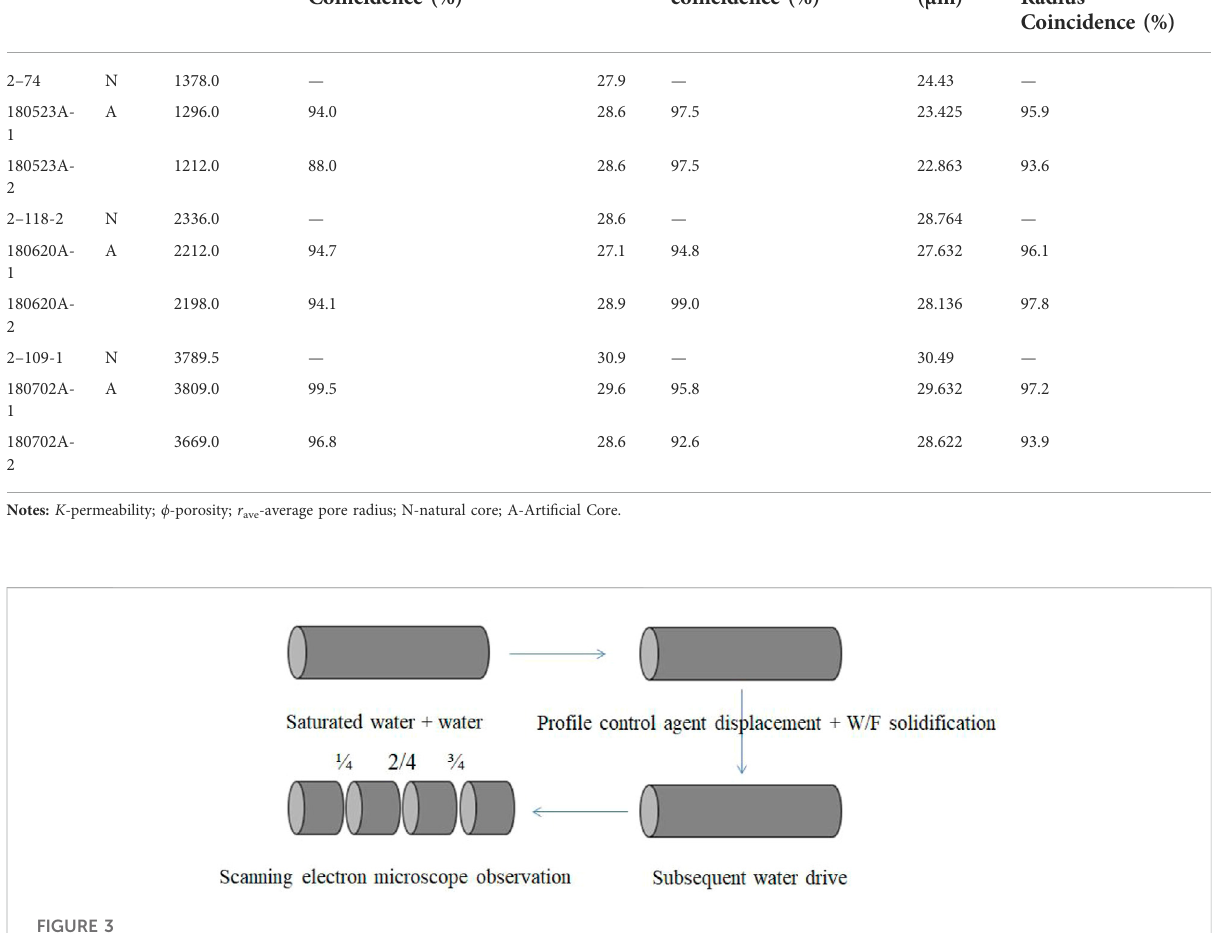
FIGURE 3 Schematic diagram of experimental